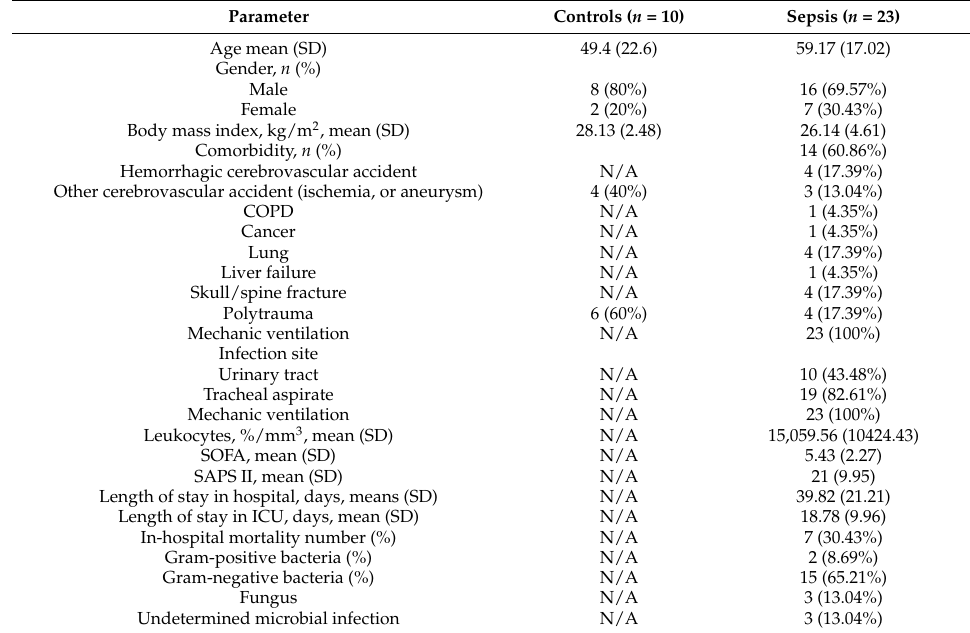
Table 1. Parameters of the studied